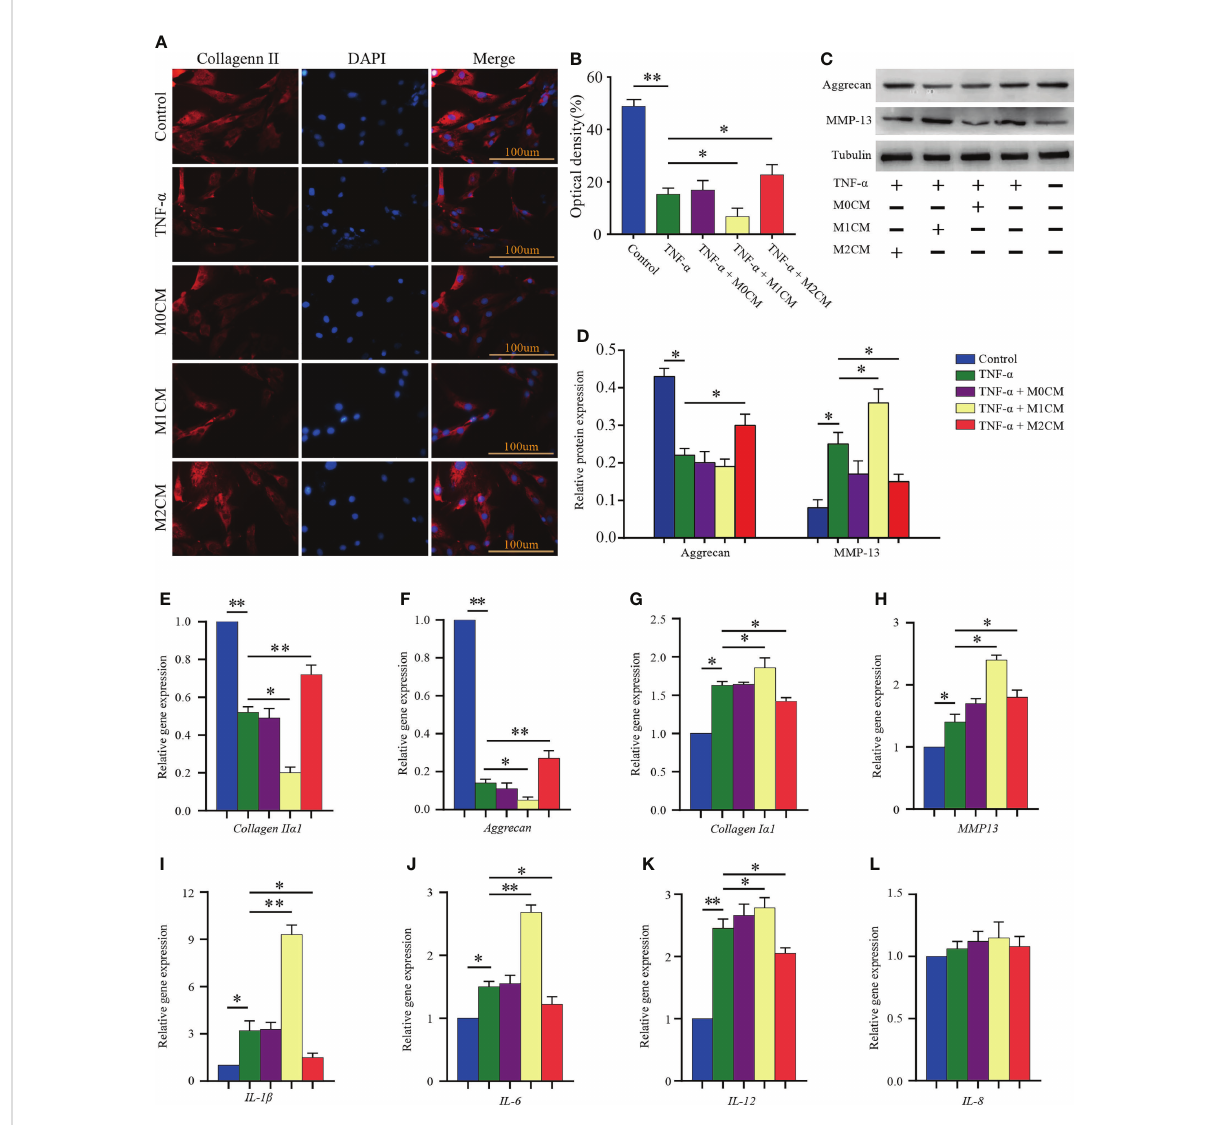
FIGURE 3 Effect of macrophage polarization on ECM synthesis and pro-in fl ammatory mediator secretion in TNF- a -treated NPCs. (A) Representative images showed collagen II immuno fl uorescence staining results corresponding to NPCs in different groups. (B) Comparison of the OD values corresponding to different test compounds after 7 days of treatment. (C, D) WB analysis of anabolic aggrecan and catabolish MMP-13in NPCs treated with different CMs for 7 days. (E – L) Gene expression of ECM components (aggrecan, collagen II a 1, and collagen I a 1), ECM-modifying enzymes (MMP-13), and pro-in fl ammatory mediators (IL-1 b , IL-6, IL-8, and IL-12) in TNF- a -treated NPCs after 3 days based on qPCR. All data are expressed as the mean ± SD, n = 3, *P < 0.05, **P < 0.01. NPCs, nucleus pulposus cells; TNF- a , tumor necrosis factor- a ; CM, condition medium; ECM, extracellular matrix; OD, optical